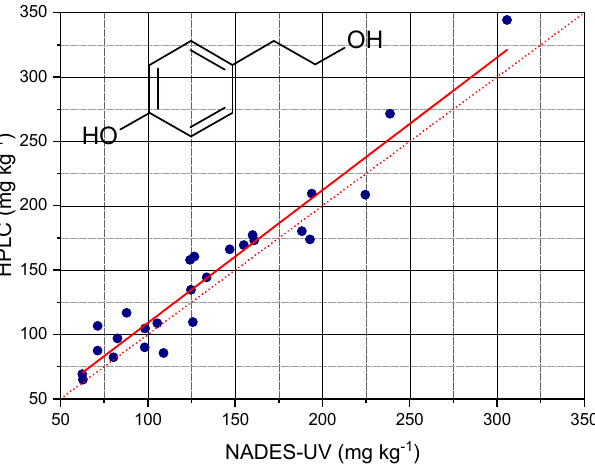
Figure 5. C ontents of total Tyr determined by HPLC after hydrolysis of the extracts plotted versus the contents of total Tyr determined by NADES extraction and UV analysis. The red dotted line has the function y = x, the red solid line is the fitted regression.